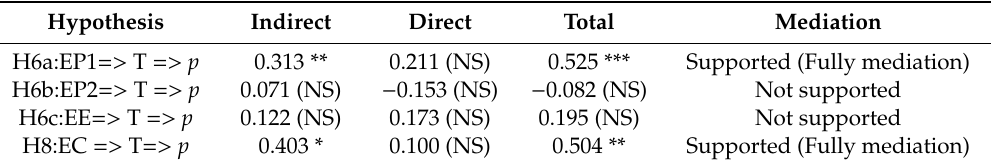
Table 6. Mediation test